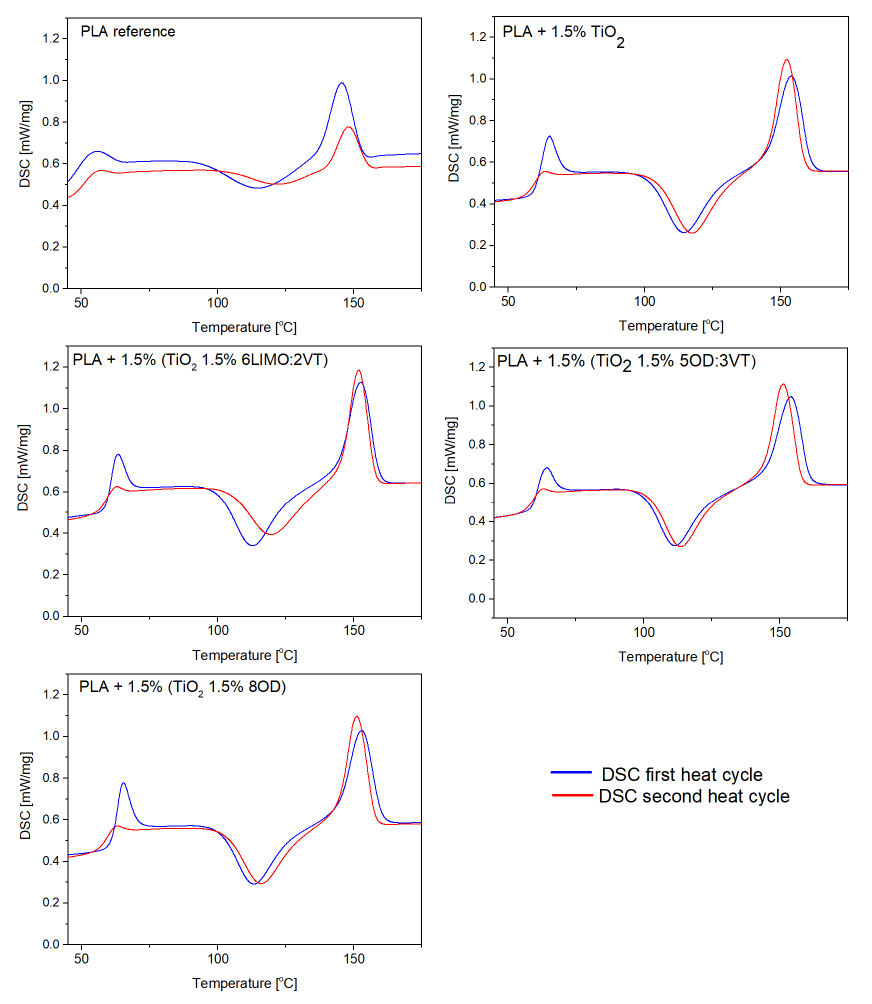
Figure 3. DSC curves of PLA/TiO 2 /modifier composites. Table 4. Results of differential scanning calorimetry